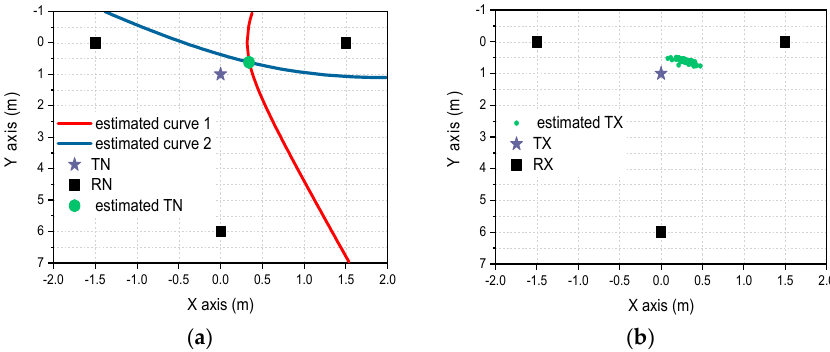
Figure 9. ( a ) Position estimation of one TDOA calculation. ( b ) Position estimation of 100 TDOA calculations.